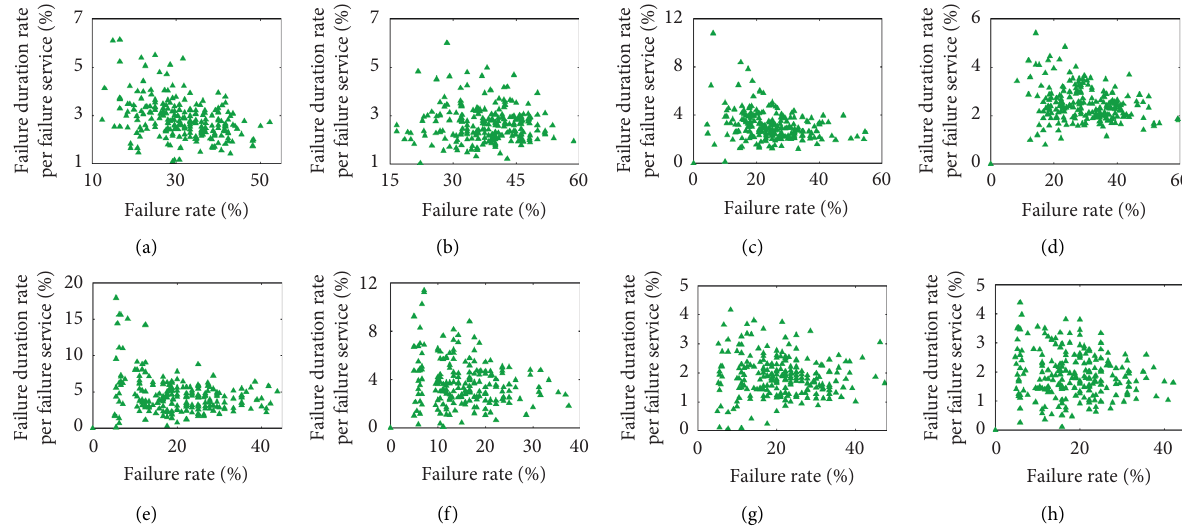
Figure 7: FDR per failure vs. FR for test bus stops. (a) No.1 bus stop. (b) No.2 bus stop. (c) No.3 bus stop. (d) No.4 bus stop. (e) No.5 bus stop. (f) No.6 bus stop. (g) No.7 bus stop. (h) No.8 bus stop.